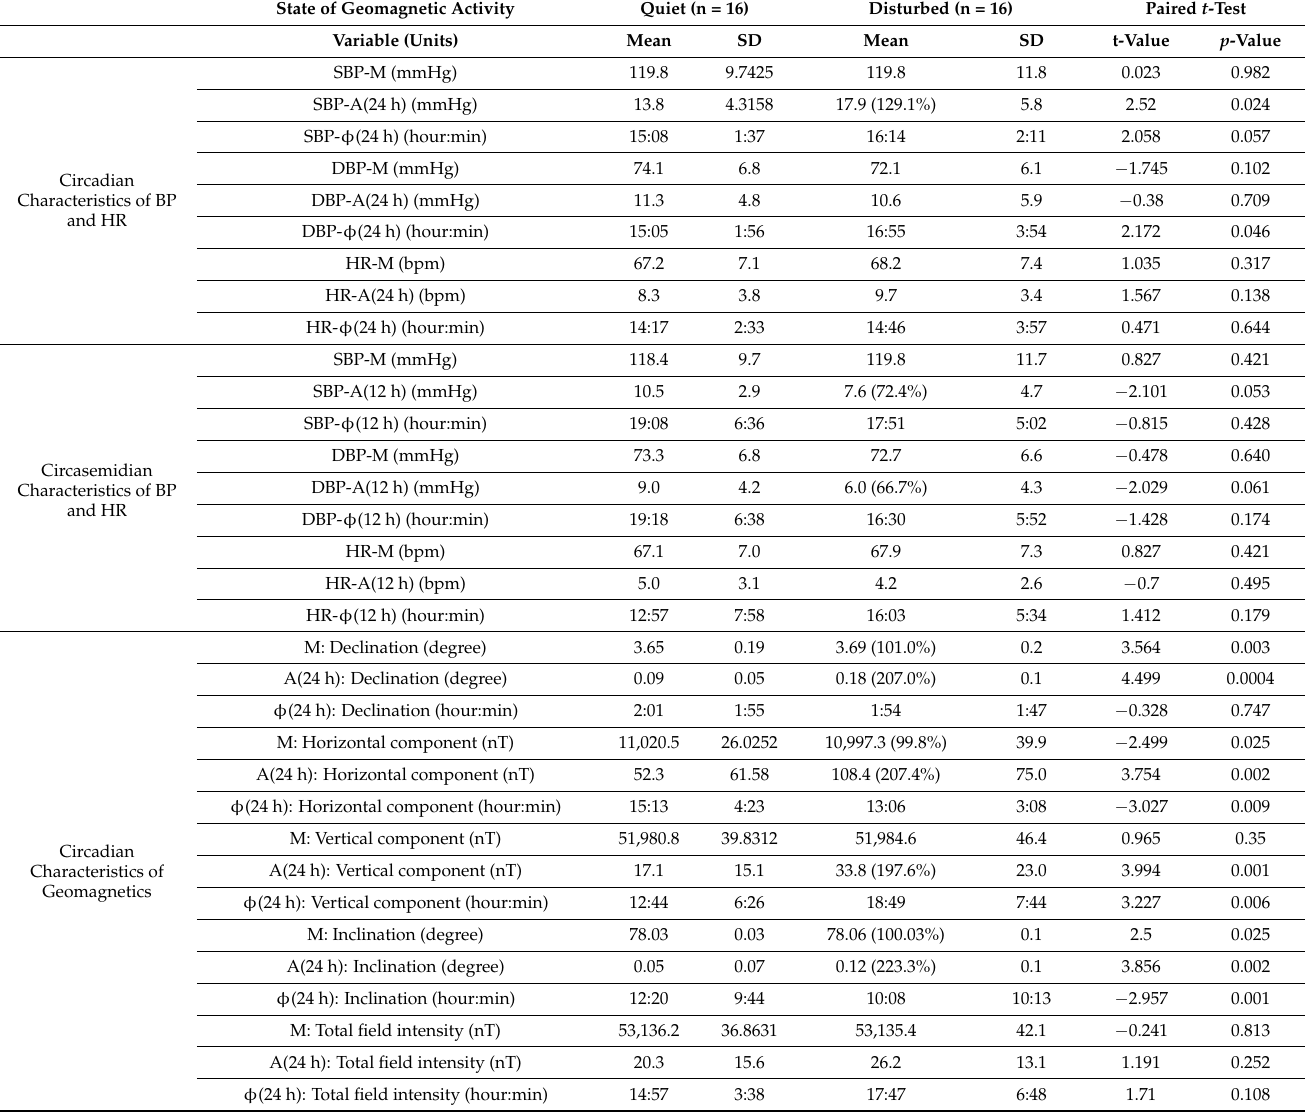
Table 1. Changes in heart-rate and blood-pressure characteristics along with geomagnetic activity observed in the 24 h